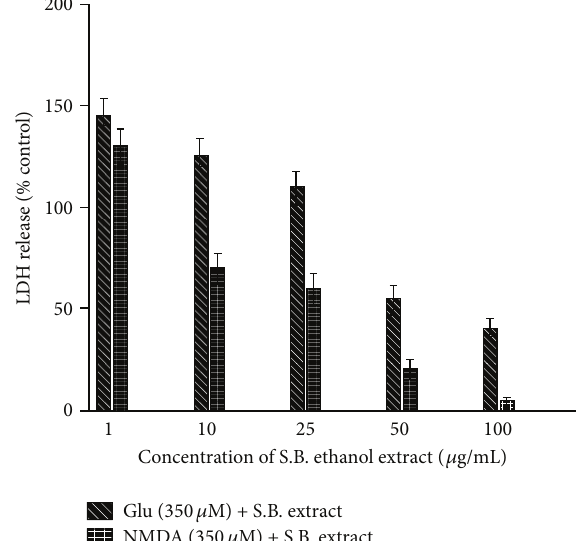
Figure 2: Inhibition of N-methyl-D-aspartate (NMDA) or glutamate- (Glu-) induced excitotoxicity by the ethanol extract of Scutellaria baicalensis (S.B.). Lactate dehydrogenase (LDH) activities given off by the damaged neurons into the culture media were measured at 20–24 h after the exposure. Data were calculated as percent of control LDH activity released into the Glu-treated culture medium. Cultures were exposed for 20 min to 350 mMGlu or NMDA in the presence of various concentrations (1, 10, 25, 50, and 100 𝜇 g/mL) of the AGR extract and maintained as described in the experimental part.